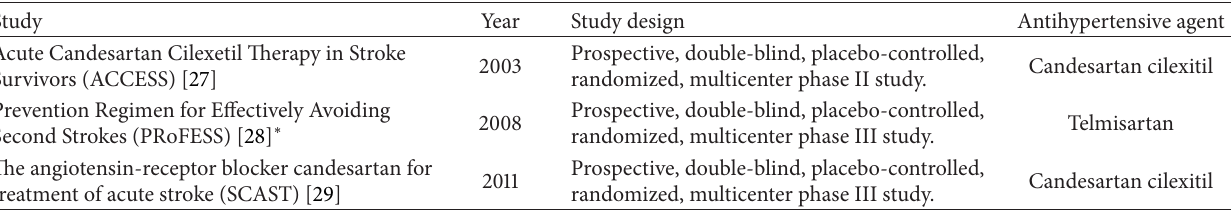
Table 1: Included trials.